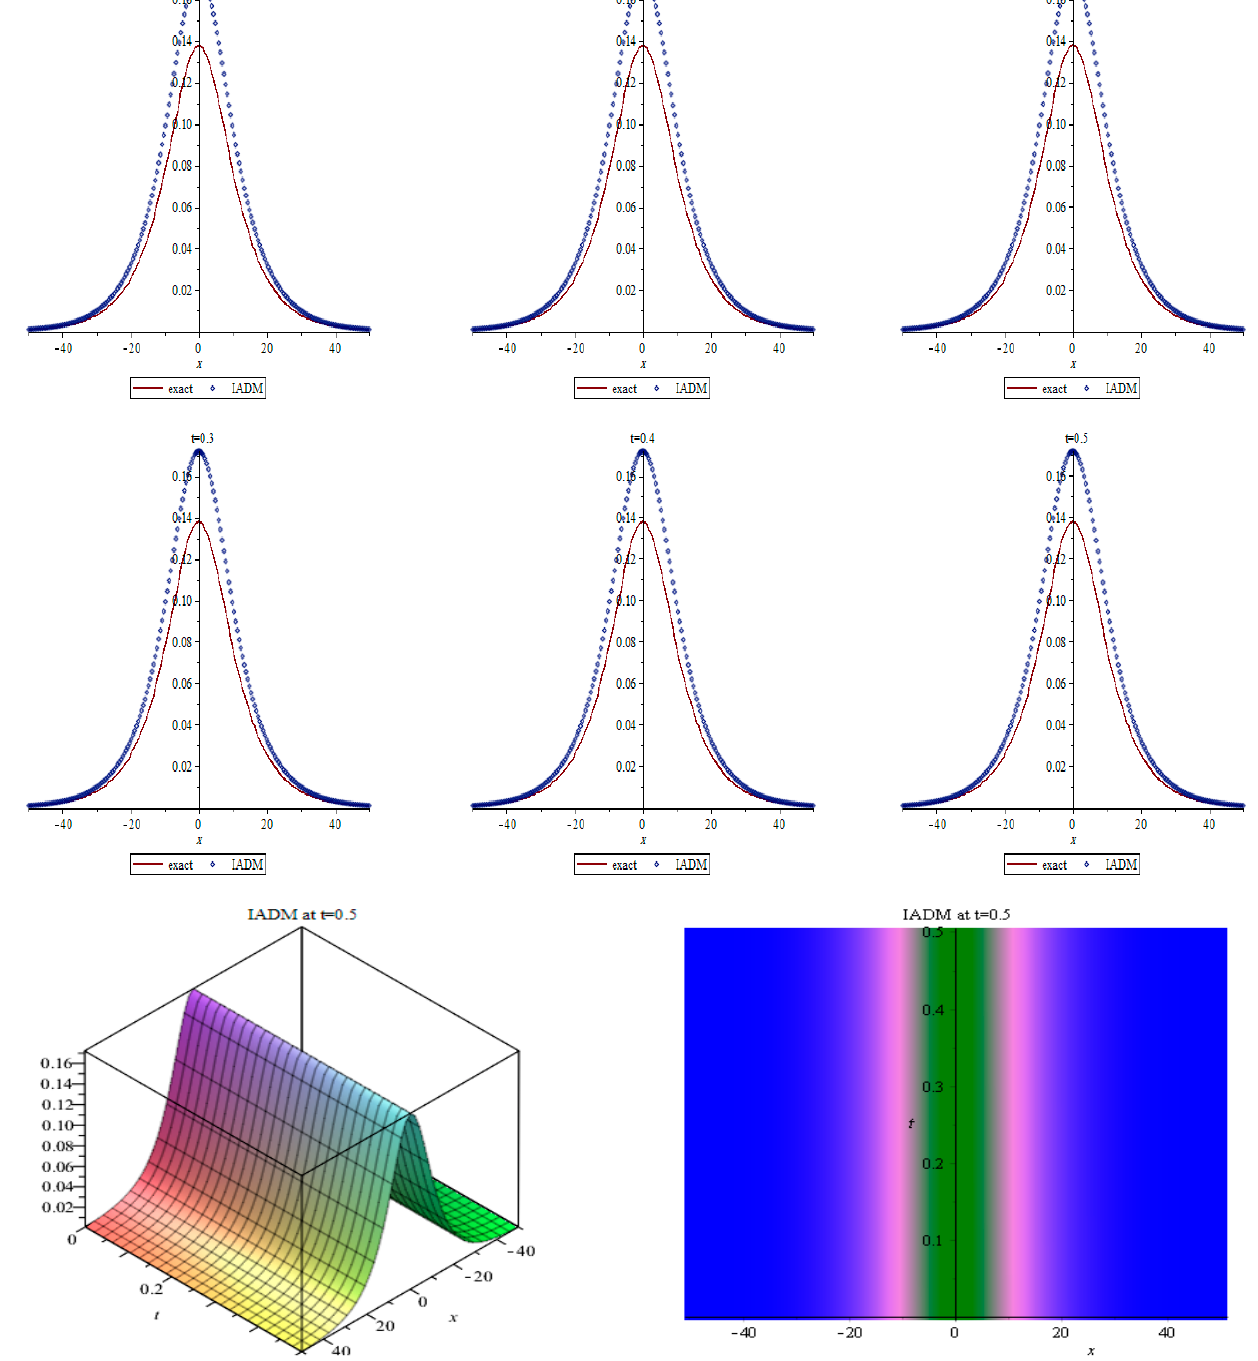
Figure 2. Comparison of the exact and improved ADM solutions for case 2 for − 50 ≤ x ≤ 50.